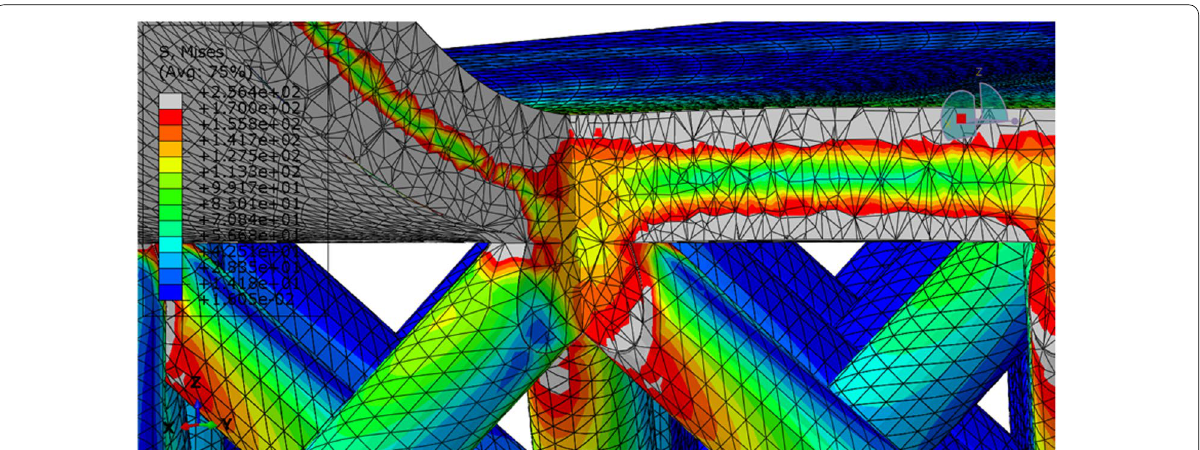
Figure 21 Section view of the specimen model at the middle joint of the outer row of cells. Zones with plastic deformation are marked